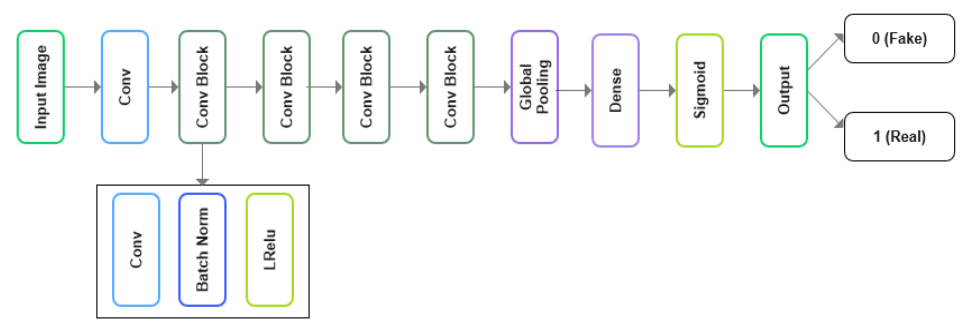
Figure 5. Discriminative Model Structure.